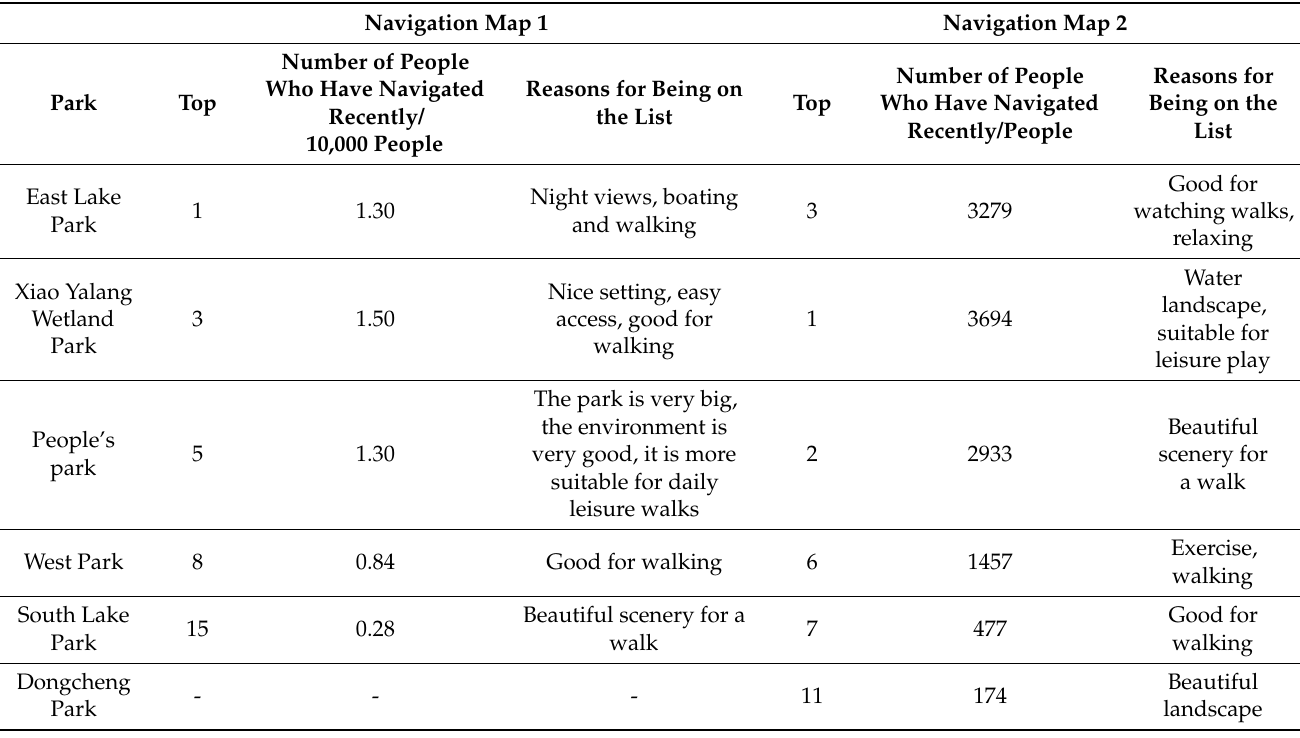
Table 3. A list of the most popular parks in the Kashgar Region was obtained by searching on the navigation map (parks in Kashgar City)